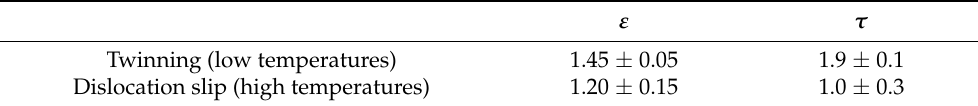
Figure 4. ( a ) Energy probability density functions at − 30 ◦ C and 50 ◦ C, ( b ) the corresponding CCDF function at − 30 ◦ C, ( c ) maximum likelihood estimation at − 30 ◦ C. Table 1. Average values of the characteristic energy and area exponents, ε and γ , according to Equation (1) at 0.15 s − 1 driving